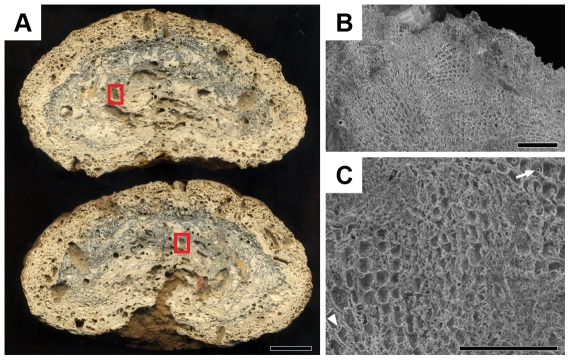
Stereomicroscopy and scanning eletron microscopy images of a isotopic dated rhodolith.(A) A section of the rhodolith made along its longest axis. The red squares indicate the regions where fragments were removed for isotopic analysis. (bar = 2 cm); (B and C) Scanning electron microscopy images showing the typical cellular organization of CCA species circumscribing the region where the fragments were collected for isotopic dating. Note in image “C" the presence of “secondary pit-connections" (arrow) and of cell fusions (arrow head) among mineralized cell walls (Bars: B = 150 um and C = 80 um).